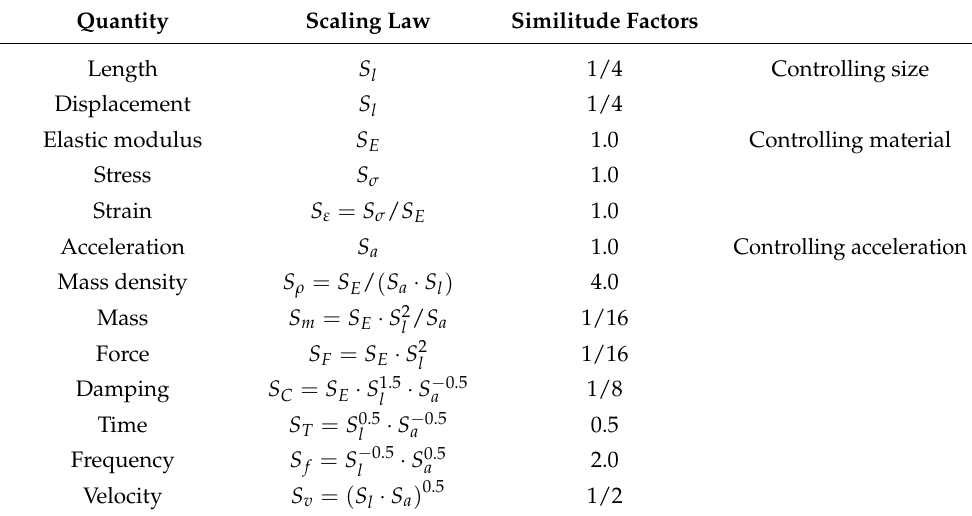
Table 1. Typical similitude factors of the model